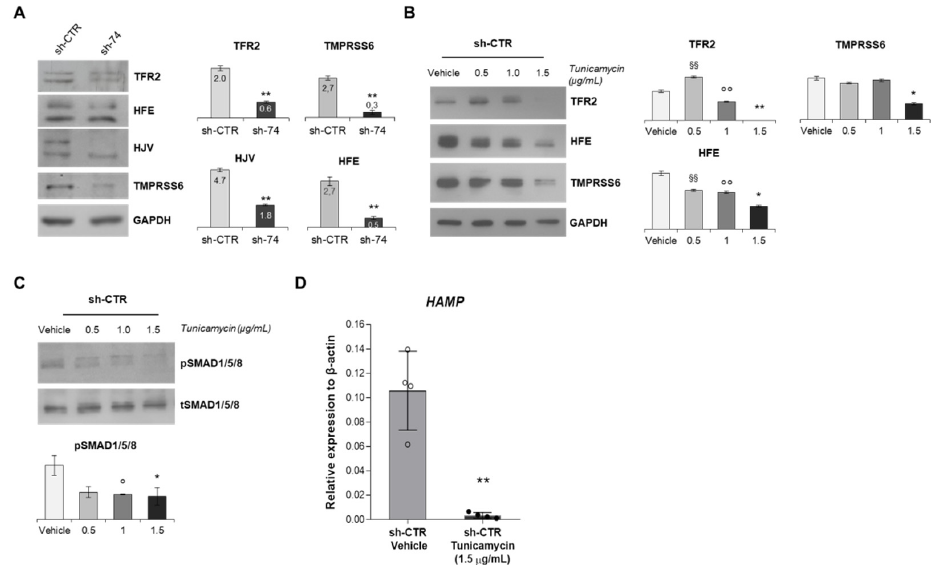
Figure 4. N-linked glycosylation is required for proper BMP/SMADs signaling . ( A ) Left panel. Representative immunoblots of TFR2, HFE, HJV, and TMPRSS6 proteins in total cells lysate of HuH7 sh-74 and sh-CTR cells. GAPDH is the loading control. Right panel. Quantification by densitometric analysis of three separate Western blots with similar results. Data are means ± standard deviation. (** p < 0.01; Student’s t -test). ( B ) Left panel . Representative immunoblots of TFR2, HFE, and TMPRSS6 in HuH7 control cells treated with DMSO (vehicle) or increasing concentration of tunicamycin (0.5, 1.0, 1.5 µg/mL). GAPDH is the loading control. Right panel . Quantification by densitometric analysis of three separate Western blots with similar results. Data are means ± standard deviation. (** p < 0.01, 1.5 µg/mL tunicamycin-treated cells vs. vehicle, °° p < 0.01 of 1.0 µg/mL tunicamycin-treated cells vs. vehicle, §§ p < 0.01 0.5 ug/mL tunicamycin-treated cells vs. vehicle; * p